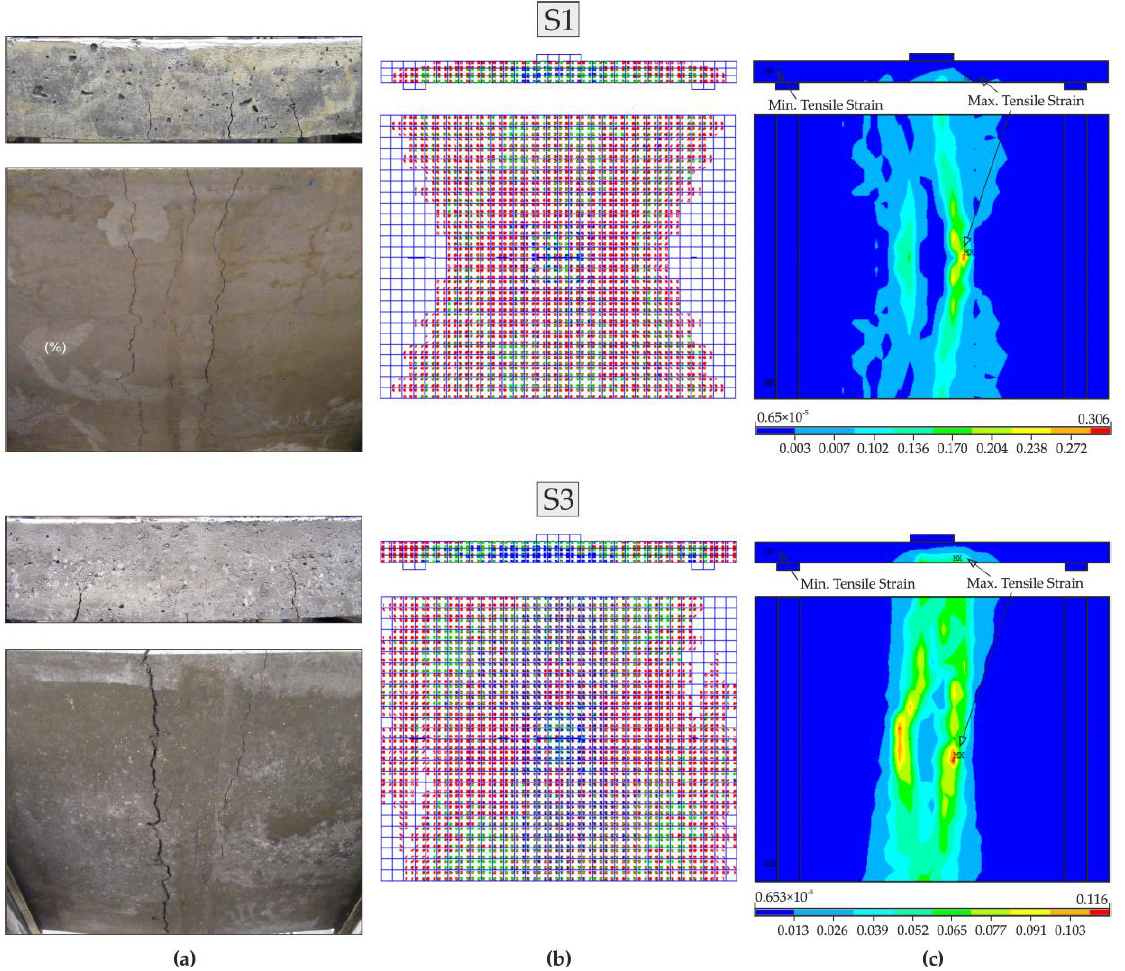
Figure 16. ( a ) Experimental and ( b ) FE crack distributions; ( c ) FE nodal solution of strains at last load step.